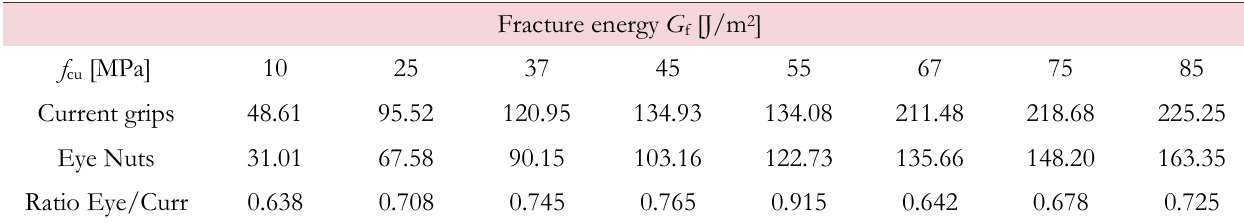
Table 4: Fracture energy values calculated according to RILEM recommendations and obtained from loading curves from numerical